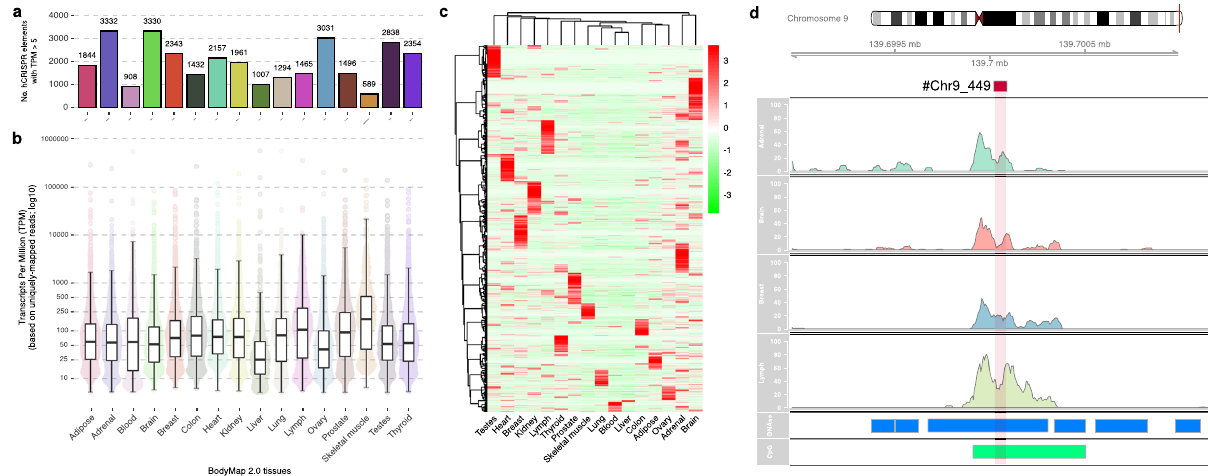
Fig. 4 A subset of the hCRISPRs is actively transcribed in healthy human tissues. a Number of hCRISPRs, with ≥ 5 TPM per tissue in 16 distinct RNA- sequenced human tissues from the Illumina BodyMap 2.0 cohort. b Boxplots representing the TPM of the hCRISPRs in 16 distinct RNA-sequenced human tissues from the Illumina BodyMap 2.0 cohort; median, Q1 and Q3 are highlighted with a bold black line and error bars, respectively. The y -axis is displayed in log 10 -scale. c Unsupervised clustering (Euclidean; Ward.D2) of TPM (as Z-scores) of all hCRISPRs with ≥ 100 TPM in at least one BodyMap tissue ( n = 3258). Negative Z-scores are highlighted in green whilst positive Z-scores are highlighted in red colors. d Example of a hCRISPR (#chr9_449 located at chr9:136805479-136805563 on hg19) which overlaps with a known human gene and shows transcriptional activity within several human BodyMap 2.0 tissues. Upper tracks display the ideogram (hg19) and genomic location with ticks per 5000 bp, the third to seventh track display the expression pro fi le (number of primary-aligned reads) per tissue (Adrenal gland, Brain, Breast, and Lymph Node). Lower tracks display overlapping DNase I clusters (in blue) and CpG islands (in